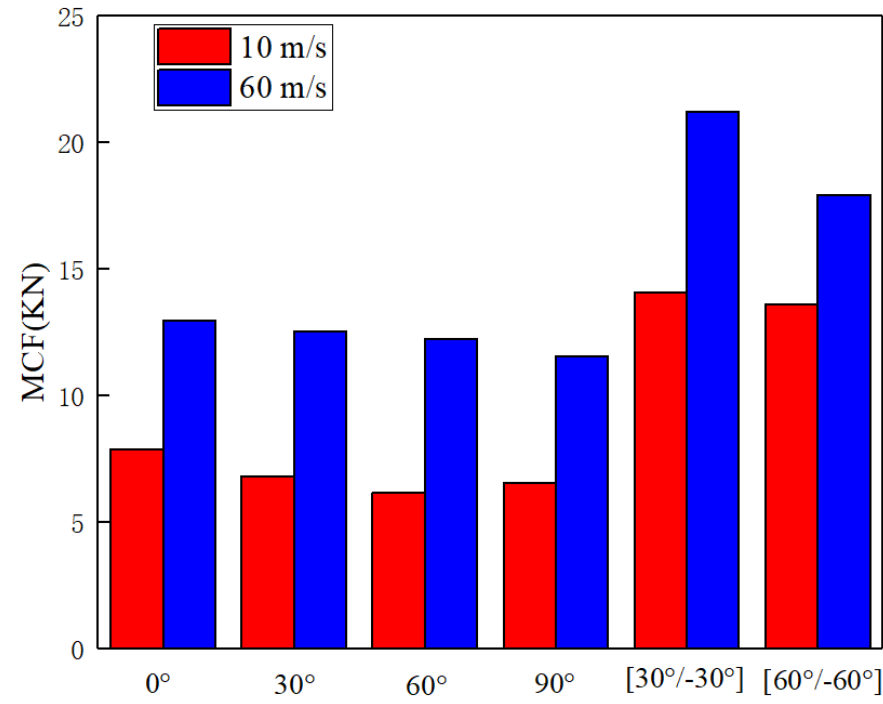
Figure 20. The MCF of RHCSs.